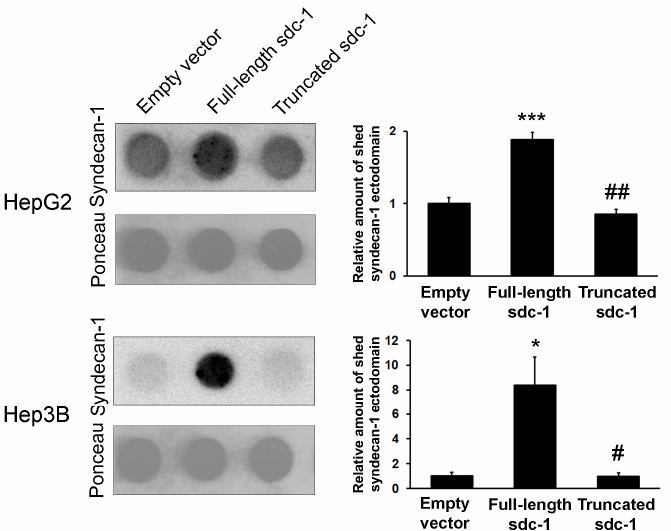
Figure 4. Shedding of syndecan-1 ectodomain. The amount of shed (soluble) syndecan-1 ectodomain was measured from cell culture media (CCM) by ectodomain-specific antibody. Shedding of the ectodomain was increased in full-length transfectants, whereas it remained unchanged in truncated transfectants in spite of the overall increased abundance of endogenous syndecan-1 (see Figure 3B). Data points represent the mean ± SD, n = 2; * p < 0.05; *** p < 0.001 versus the empty vector transfectant; # p < 0.05; ## p < 0.01 versus the full-length sdc-1 transfectant. The proliferation rate of truncated syndecan-1 transfectants decreased significantly in both hepatoma cell lines (Student’ t -test, HepG2 p < 0.001 and Hep3B p < 0.001) (Figure 5A,B). In HepG2, the generation time increased from 39.4 to 49.2 h (by 24.9%) and to 64 h (by 62.7%) in full-length and truncated syndecan-1 transfectants, respectively, whereas in Hep3B, it was increased from 34.6 to 52.4 h (by 51.2%) in truncated syndecan-1 transfectants as compared with the empty vector control. For both cell lines, the difference between control and truncated transfectants was significant at p <